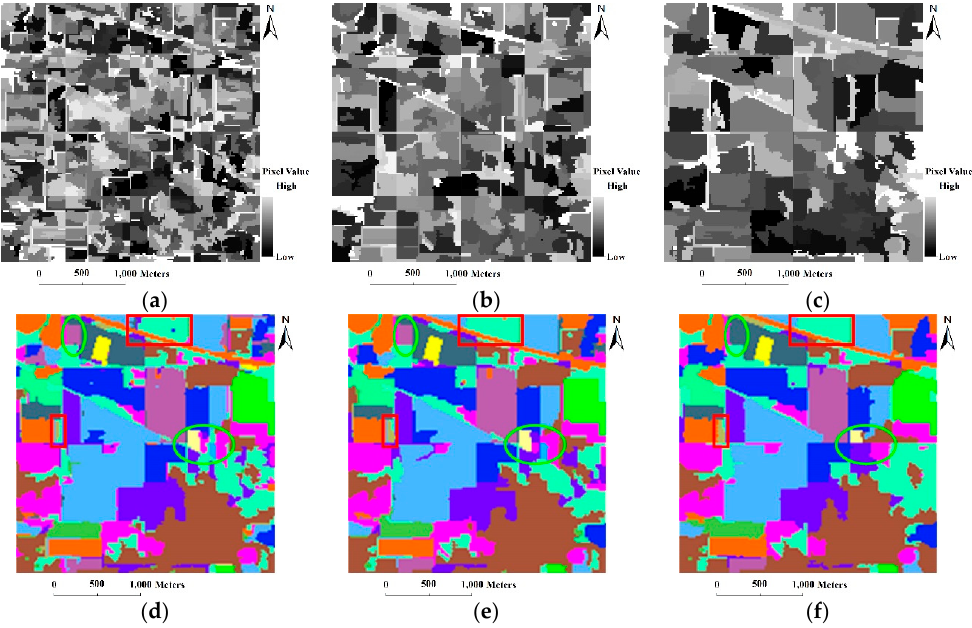
Figure 12. The segmentation and classification maps by our method with respect to different values of l . ( a ) the segmentation map ( l = 4); ( b ) the classification map ( l = 4); ( c ) the segmentation map ( l = 5); ( d ) the classification map ( l = 5); ( e ) the segmentation map ( l = 6); ( f ) the classification map ( l = 6). Table 5. The GAs and CAs (percent) produced by our method using different values of l from 4 to 6 for the Indian Pines image. The highest accuracies are indicated in bold in each category.